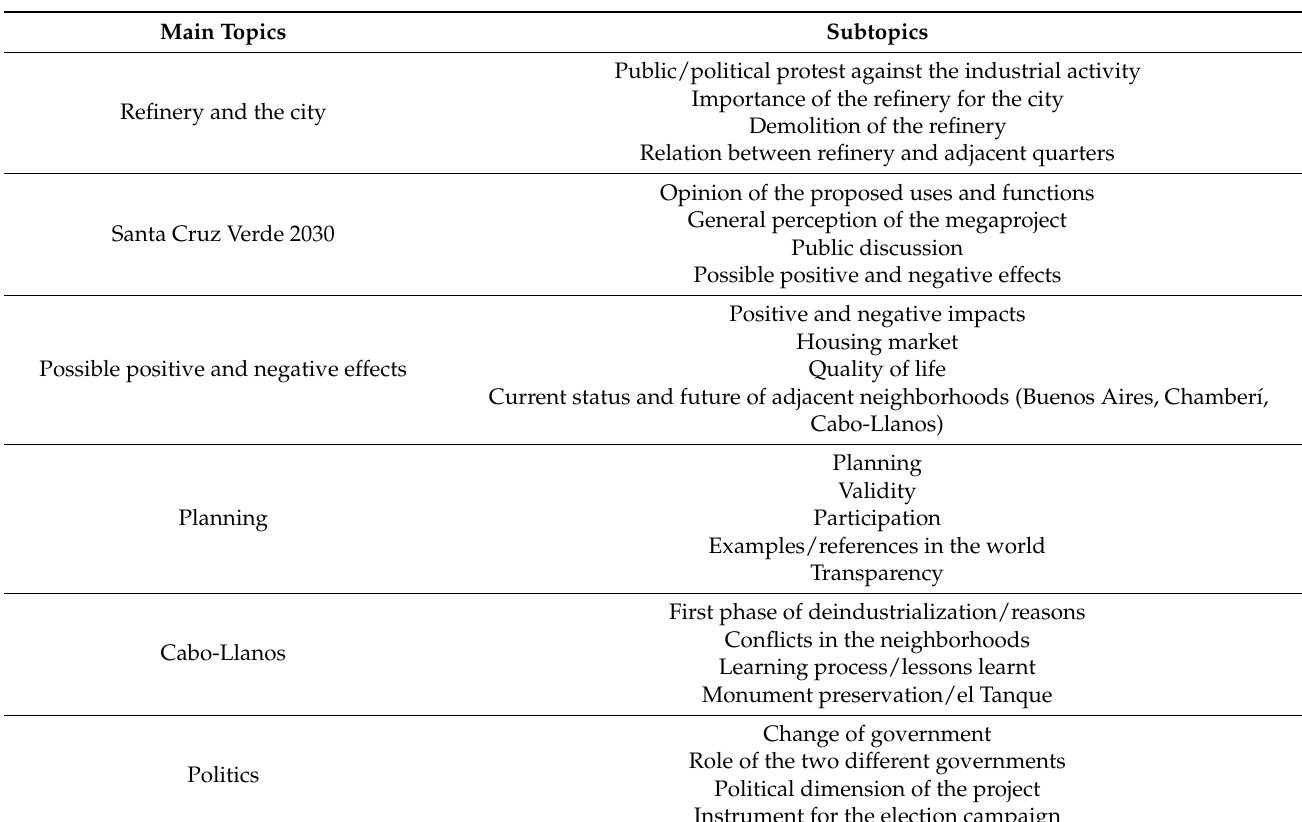
Table 2. Guideline of the